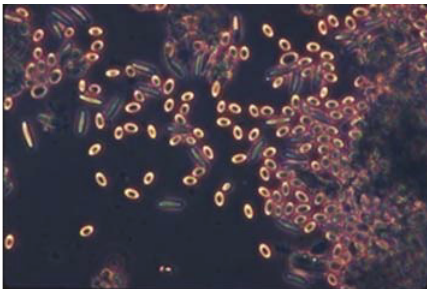
Figure 3: Phase contrast view (400x) of ovoid meiospores (octospores) and bacilliform binucleate free spores of Vairimorpha invictae in workers of Solenopsis invicta. Again, most octects with meiospores brake during the grinding